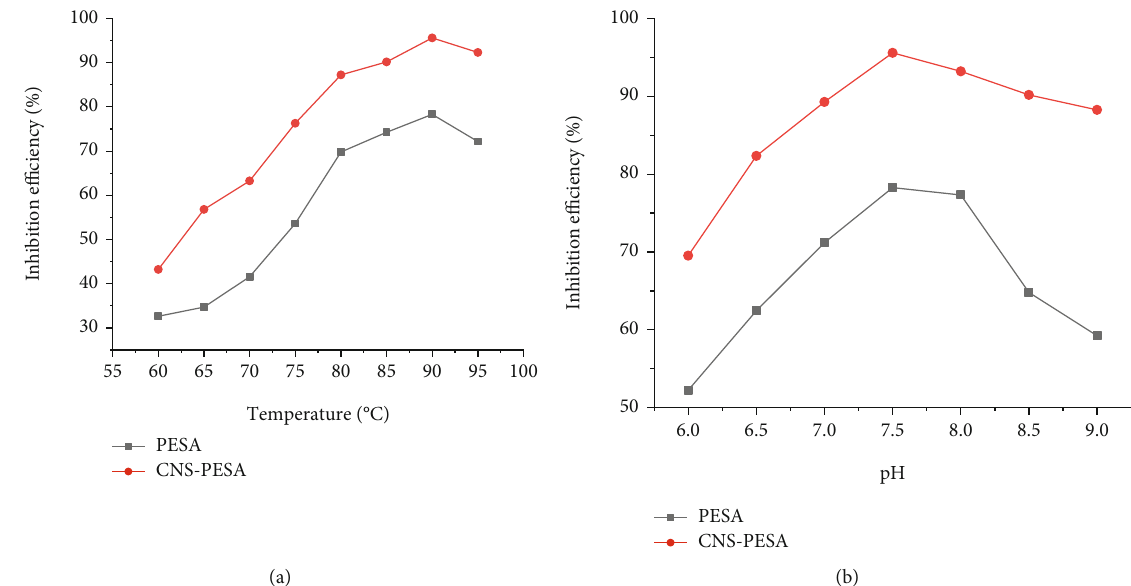
Figure 10: E ff ect of corrosion inhibition performance for PESA and CNS-PESA on (a) di ff erent reaction temperatures and (b) di ff erent pH.